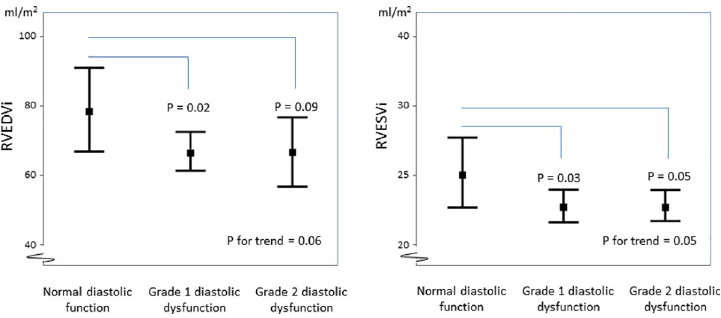
Fig 1. RV end-diastolic and end-systolic volume indices according to LV diastolic function. RVEDVi = right ventricular end-diastolic volume index, RVESVi = right ventricular end-systolic volume index.